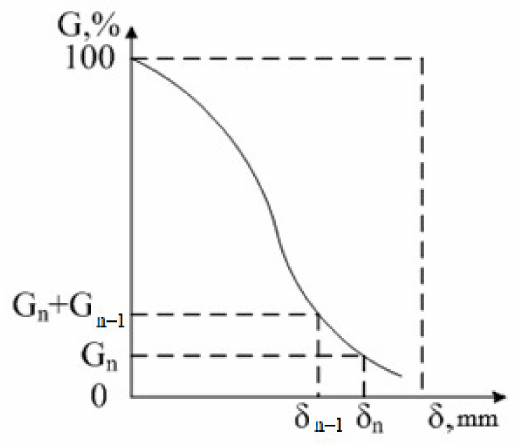
Figure 3. Integral